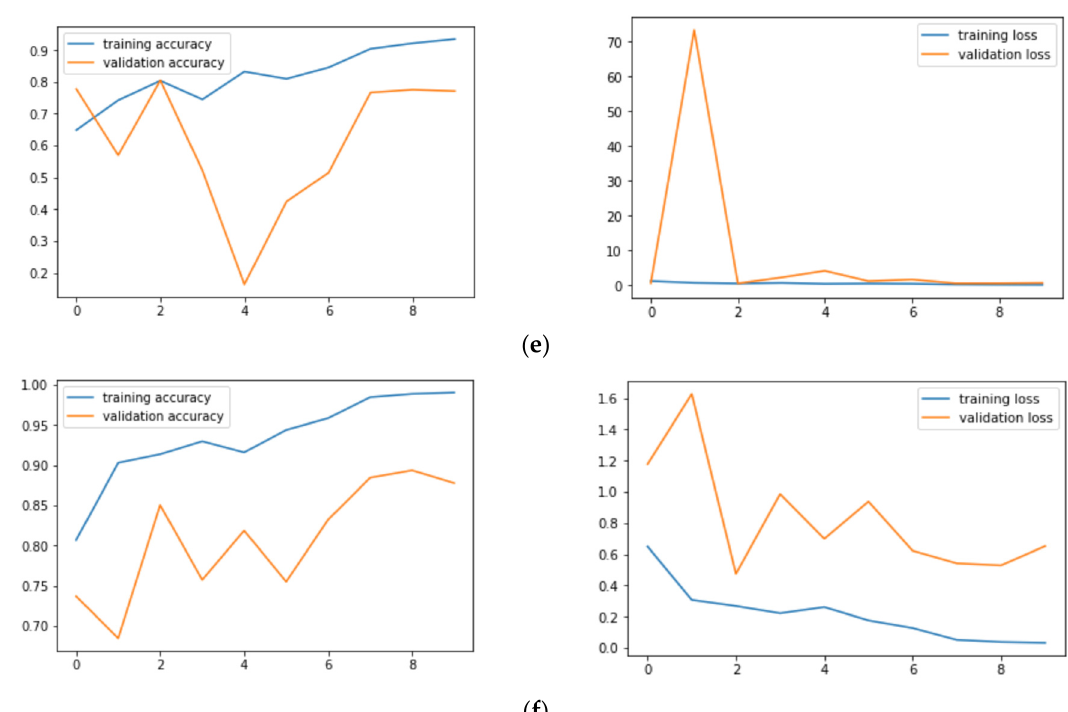
Figure 6. Training and validation accuracies and training and validation loss: ( a ) VGG19; ( b ) InceptionV3; ( c ) InceptionResNetV2; ( d ) ResNet50; ( e ) Xception; ( f ) MobileNet.